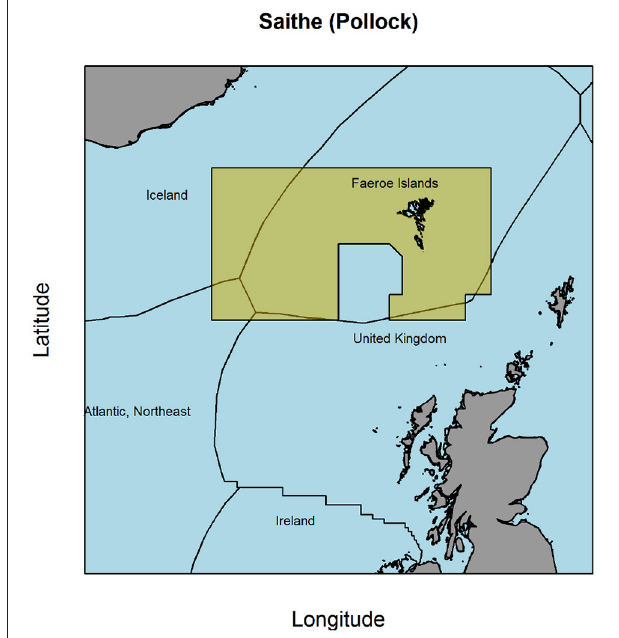
FIGURE 1 | Example of transboundary stock. This pollock (also known as saithe) stock spans the EEZs of Iceland, the United Kingdom, and the Faeroe Islands. The stock also spans the high seas, outside of any national